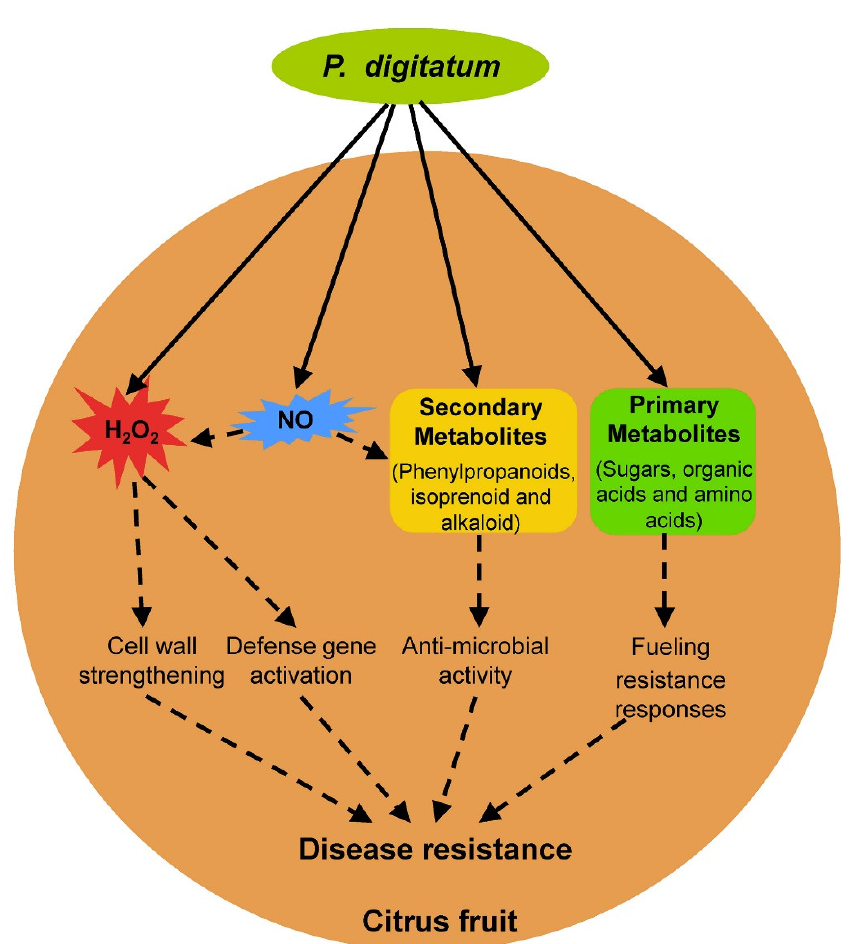
Figure 2. Overview of resistance responses in citrus fruit against Penicillium digitatum infection. Solid and dotted arrows indicate direct and tentative stimulatory modification, respectively.